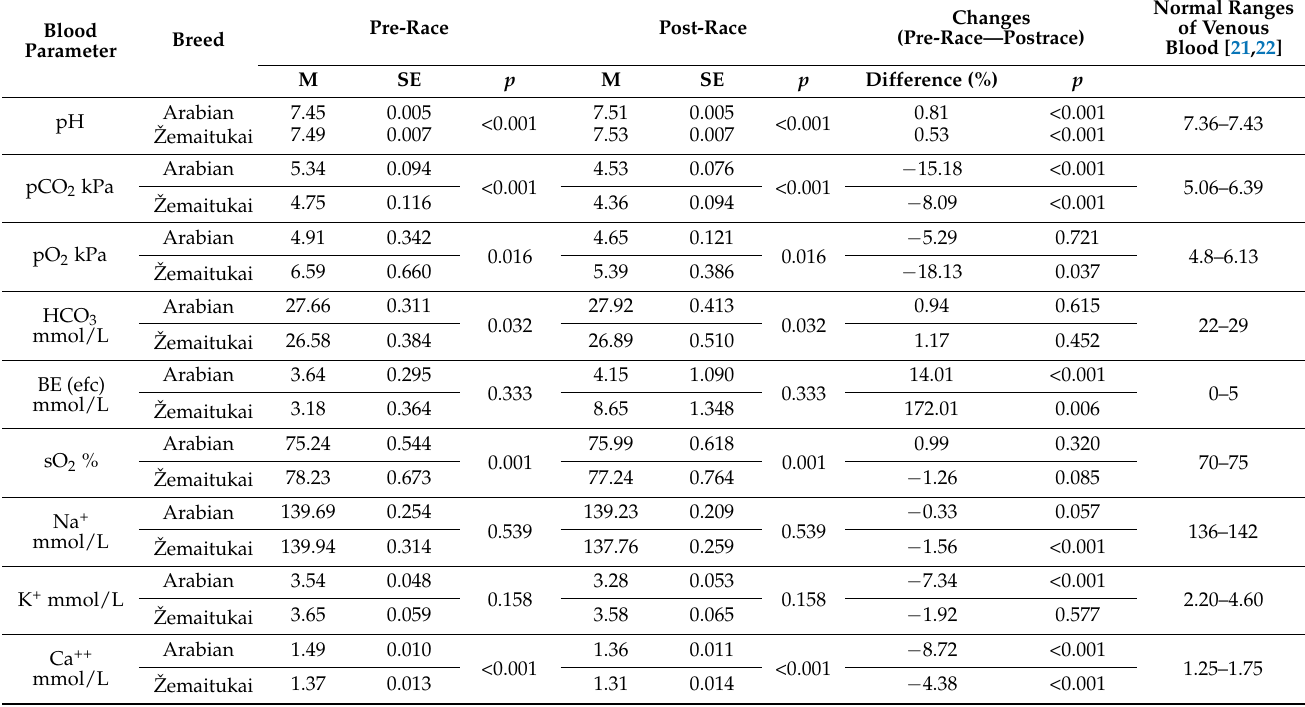
Table 2. The indices of electrolyte and acid–base balance in the Arabian and Žemaitukai horses before and after competition. Blood Parameter